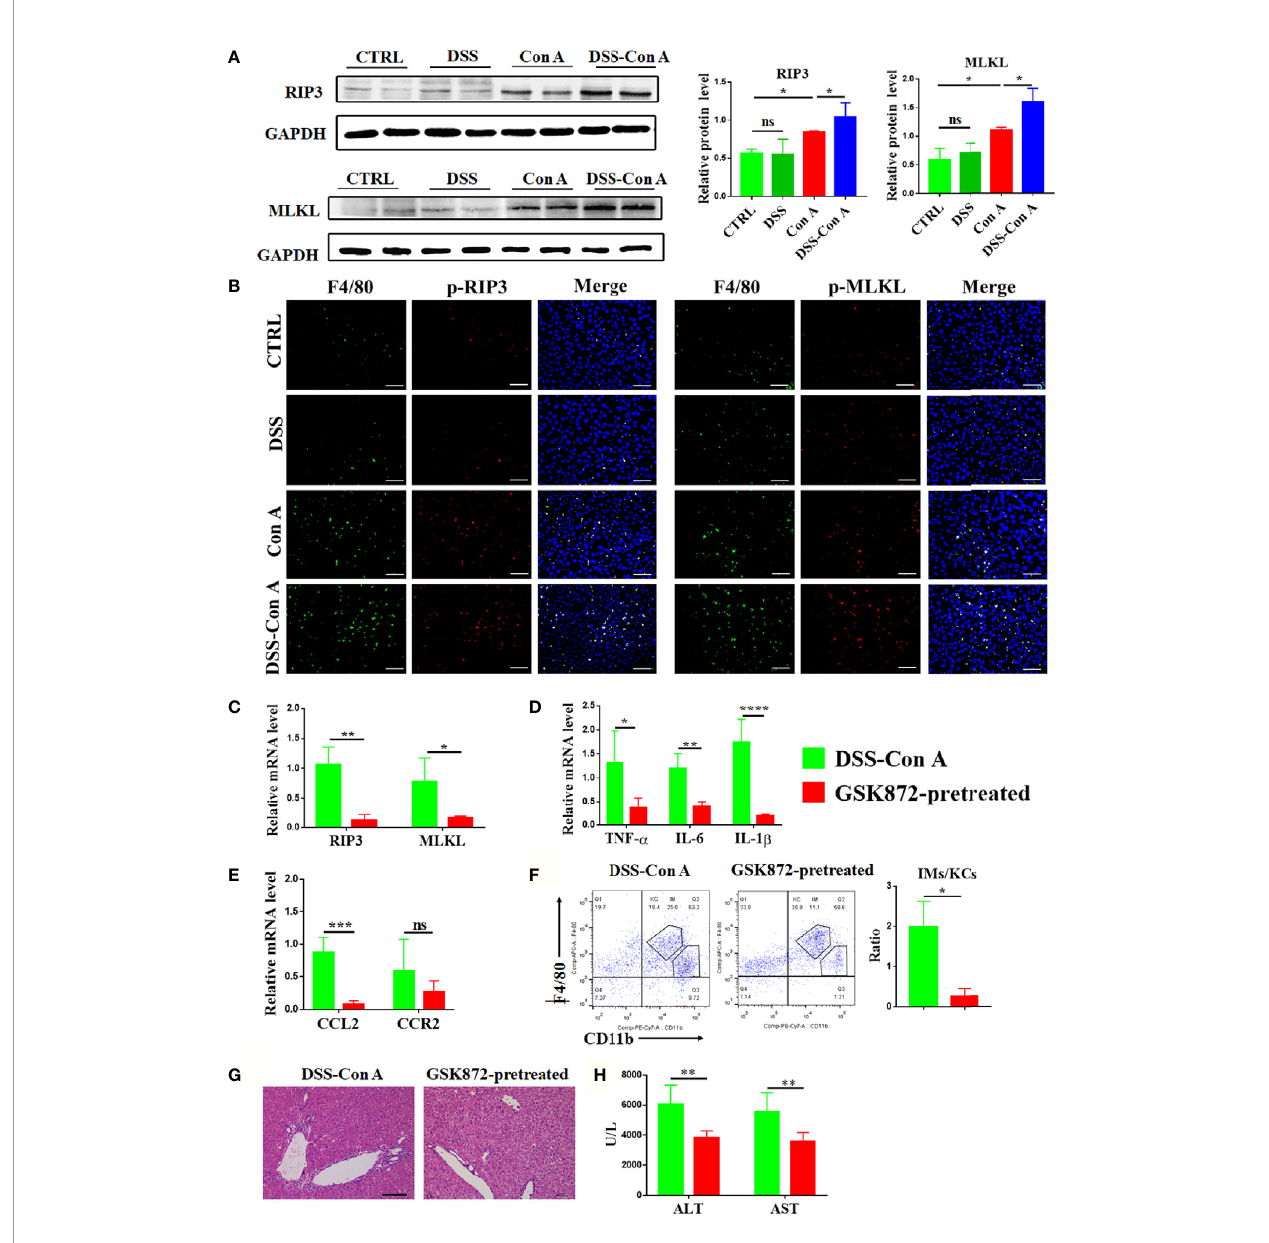
FIGURE 5 | Breakage of intestinal barrier aggravated the activation of RIP3 signaling pathway of the liver tissue. (A) Protein levels of RIP3 and MLKL in the liver of the four groups were detected and the relative intensity was quanti fi ed. (B) Representative double-immuno fl uorescence staining for F4/80 and p-RIP3, F4/80 and p-MLKL of liver tissues in four groups. (C) RT-qPCR analysis of RIP3 and MLKL on liver tissue of DSS-ConA group and GSK872-pretreated group. (D) RT-qPCR analysis of TNF- a , IL-6, and IL-1 b on liver tissue of the two groups. (E) RT-qPCR analysis of CCL2 and CCR2 on liver tissue of the two groups. (F) Representative fl ow cytometry plots and percentage of CD45 + F4/80 hi CD11b lo Kupffer cells and CD45 + F4/80 lo CD11b hi in fi ltrating macrophages in mononuclear cells from liver of the two groups. (G) HE staining of the liver tissue from the two groups. (H) The plasma concentrations of ALT and AST of the two groups. (n=6). Scale bars: 50 m m. The data were presented as means ± SD (Student ’ s t-test, *p < 0.05, **p < 0.01, ***p < 0.001, ****p < 0.0001, ns: p <